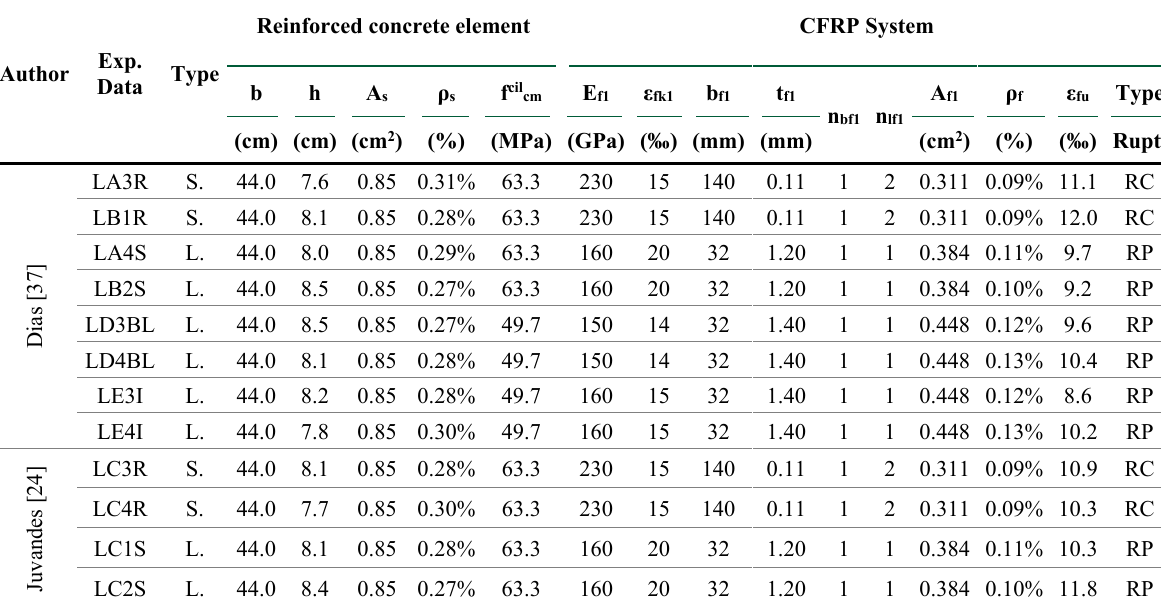
Table 1. Summary of the 12 experimental slab data used in this study*.